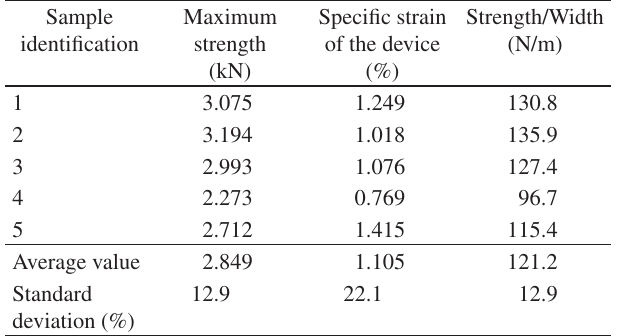
Table 7. Shear test results – Pinus elliottii.